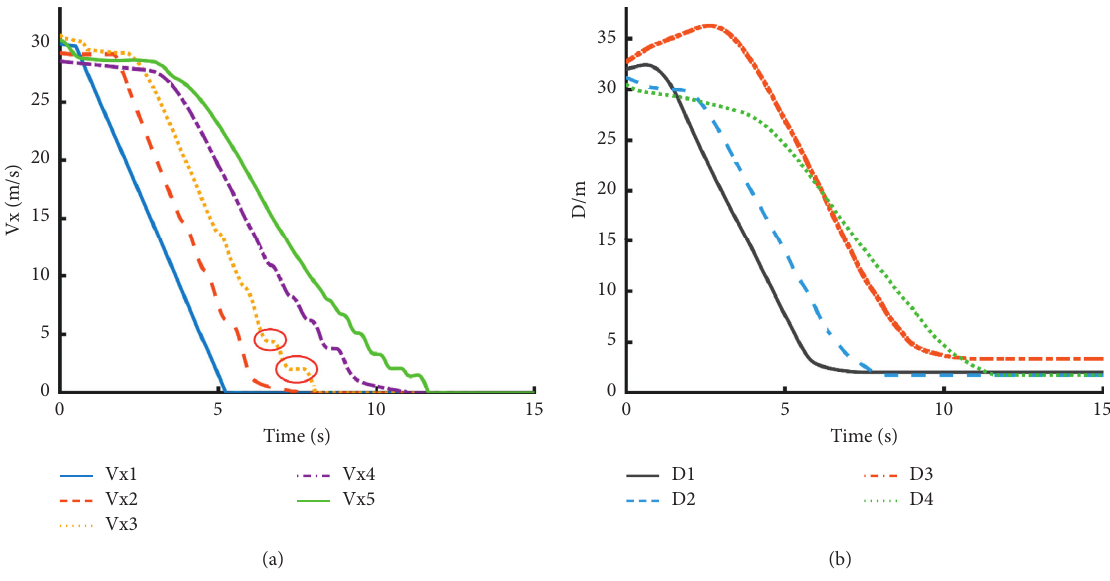
Figure 10: Test results of the mixed platoon. (a) Longitudinal velocity. (b) Intervehicle spacing.